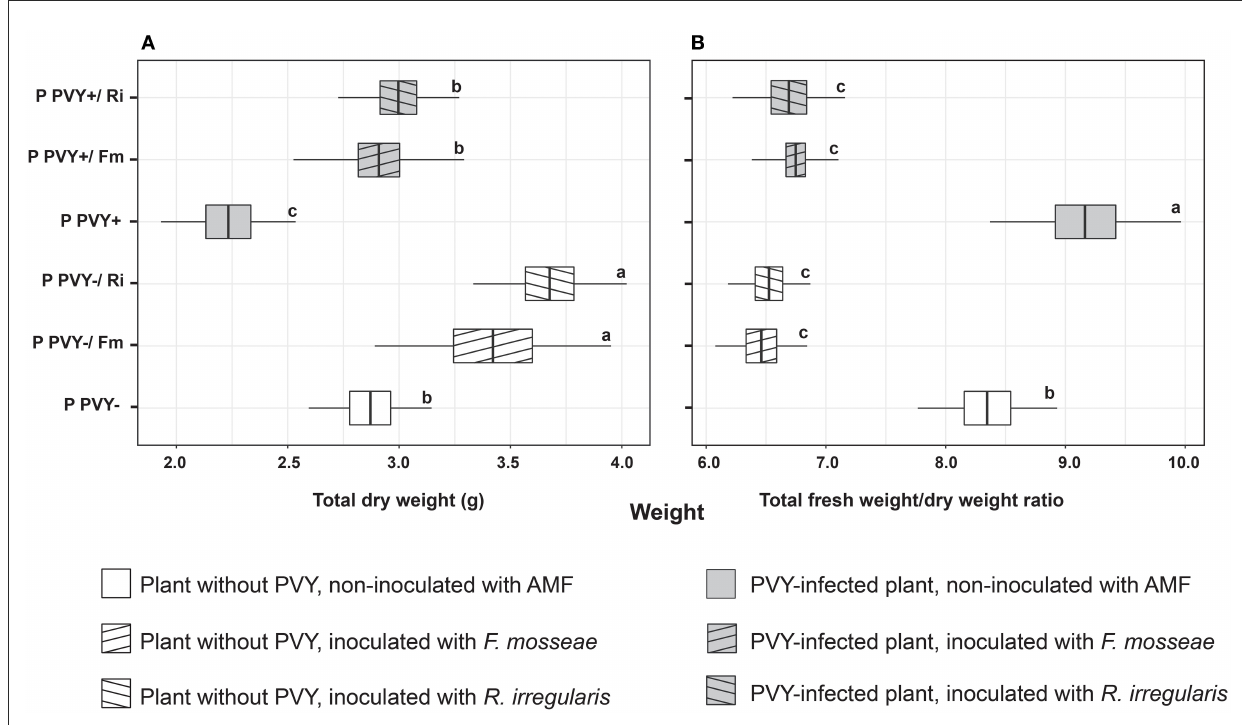
FIGURE4 The combined effect of AMF inoculation and PVY infection on potato total dry weight (A) and ratio of total fresh to dry weight (B) . The statistically significant differences are marked with letters. The same letters indicate no significant differences ( p > 0.05).